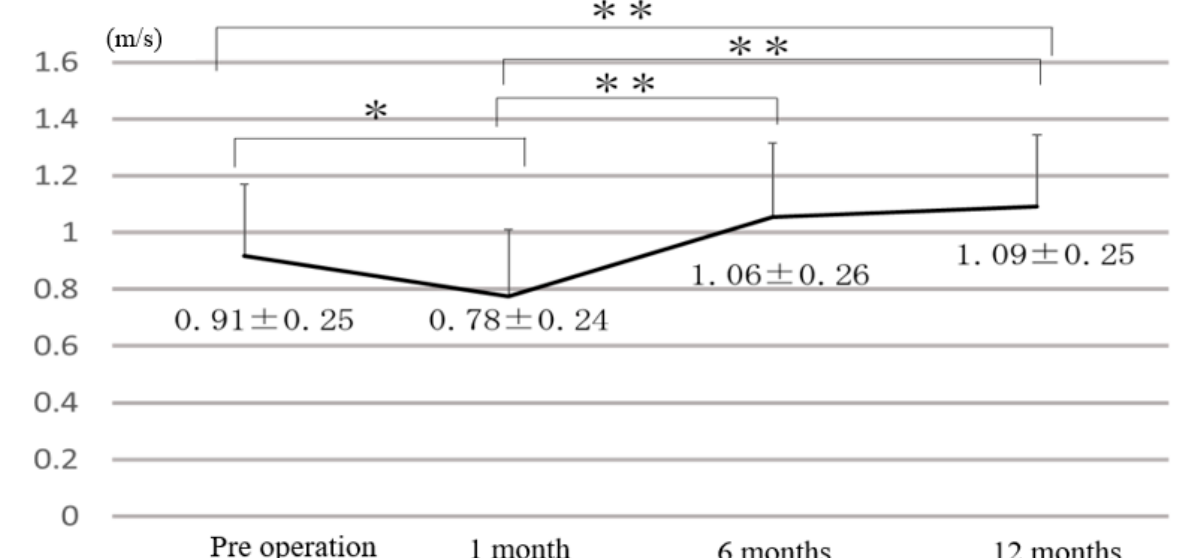
Figure 4. A 10-m walk velocity.